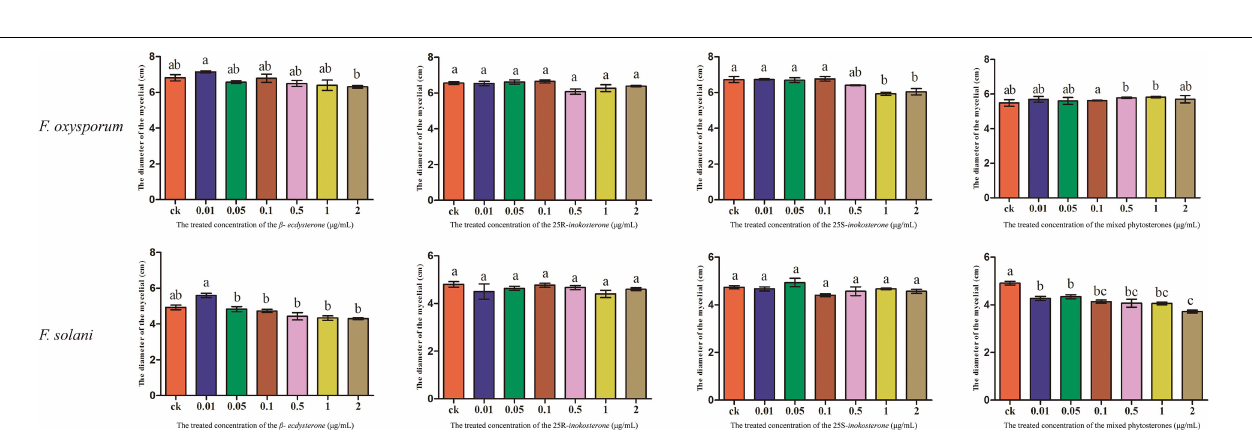
FIGURE 7 | The effects of single ( β - ecdysterone , 25R- inokosterone , and 25S- inokosterone ) and a mixture of phytosterone on the mycelial growth of F. oxysporum and F. solani . Small letters in figures show significant differences determined by Tukey’s test ( p ≤ 0.05, n = 3).